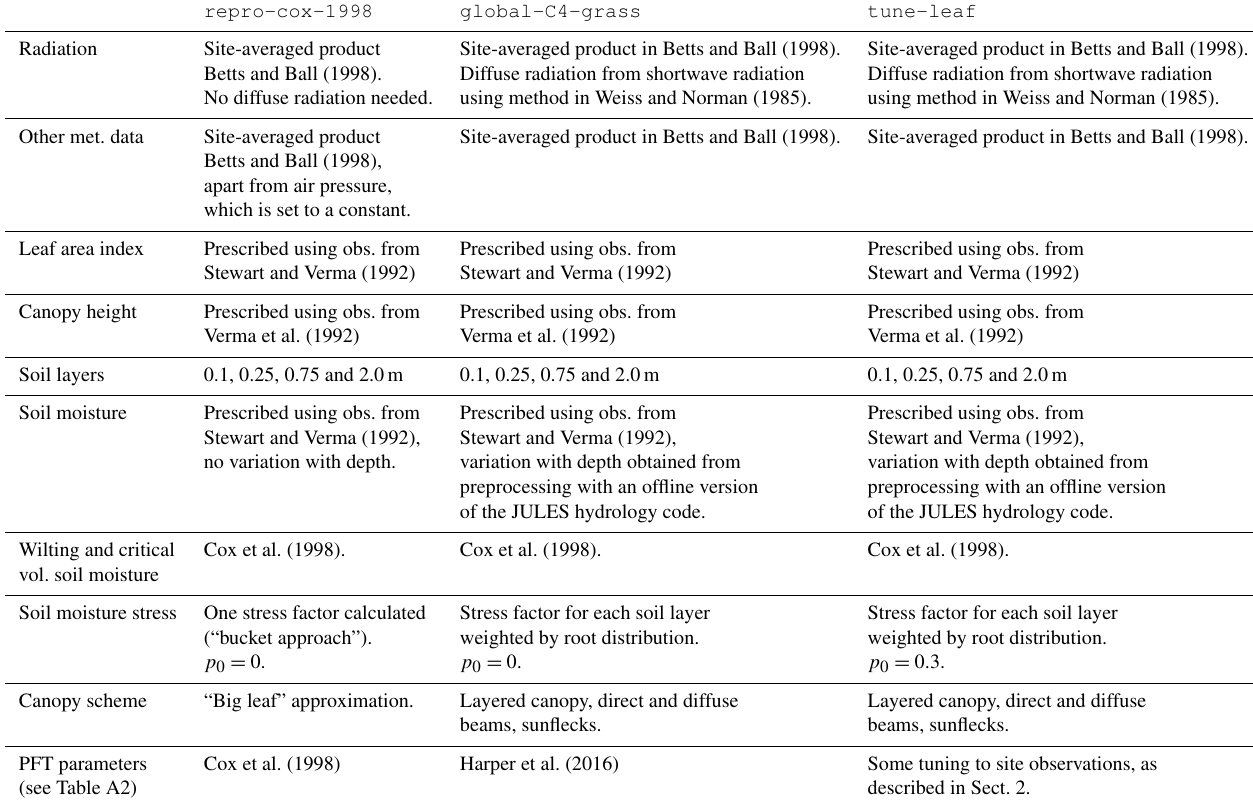
Table 1. Model settings for the runs at FIFE site 4439 for 1987. Further descriptions of the model setup can be found in Sect. 2 and the choice of FIFE observations in Sect. A. global-C4-grass tune-leaf Radiation Site-averaged product Site-averaged product in Betts and Ball (1998). Site-averaged product in Betts and Ball (1998). Betts and Ball (1998). Diffuse radiation from shortwave radiation Diffuse radiation from shortwave radiation No diffuse radiation needed. using method in Weiss and Norman (1985). using method in Weiss and Norman